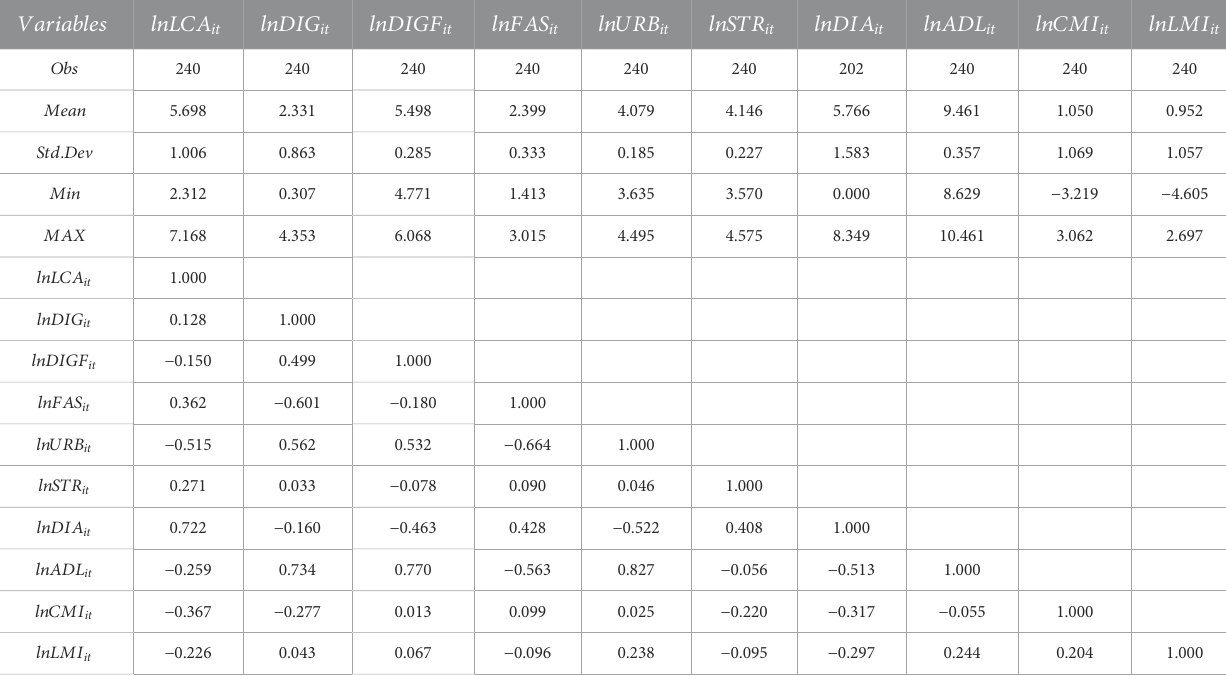
TABLE 4 Descriptive statistics and correlation matrix.